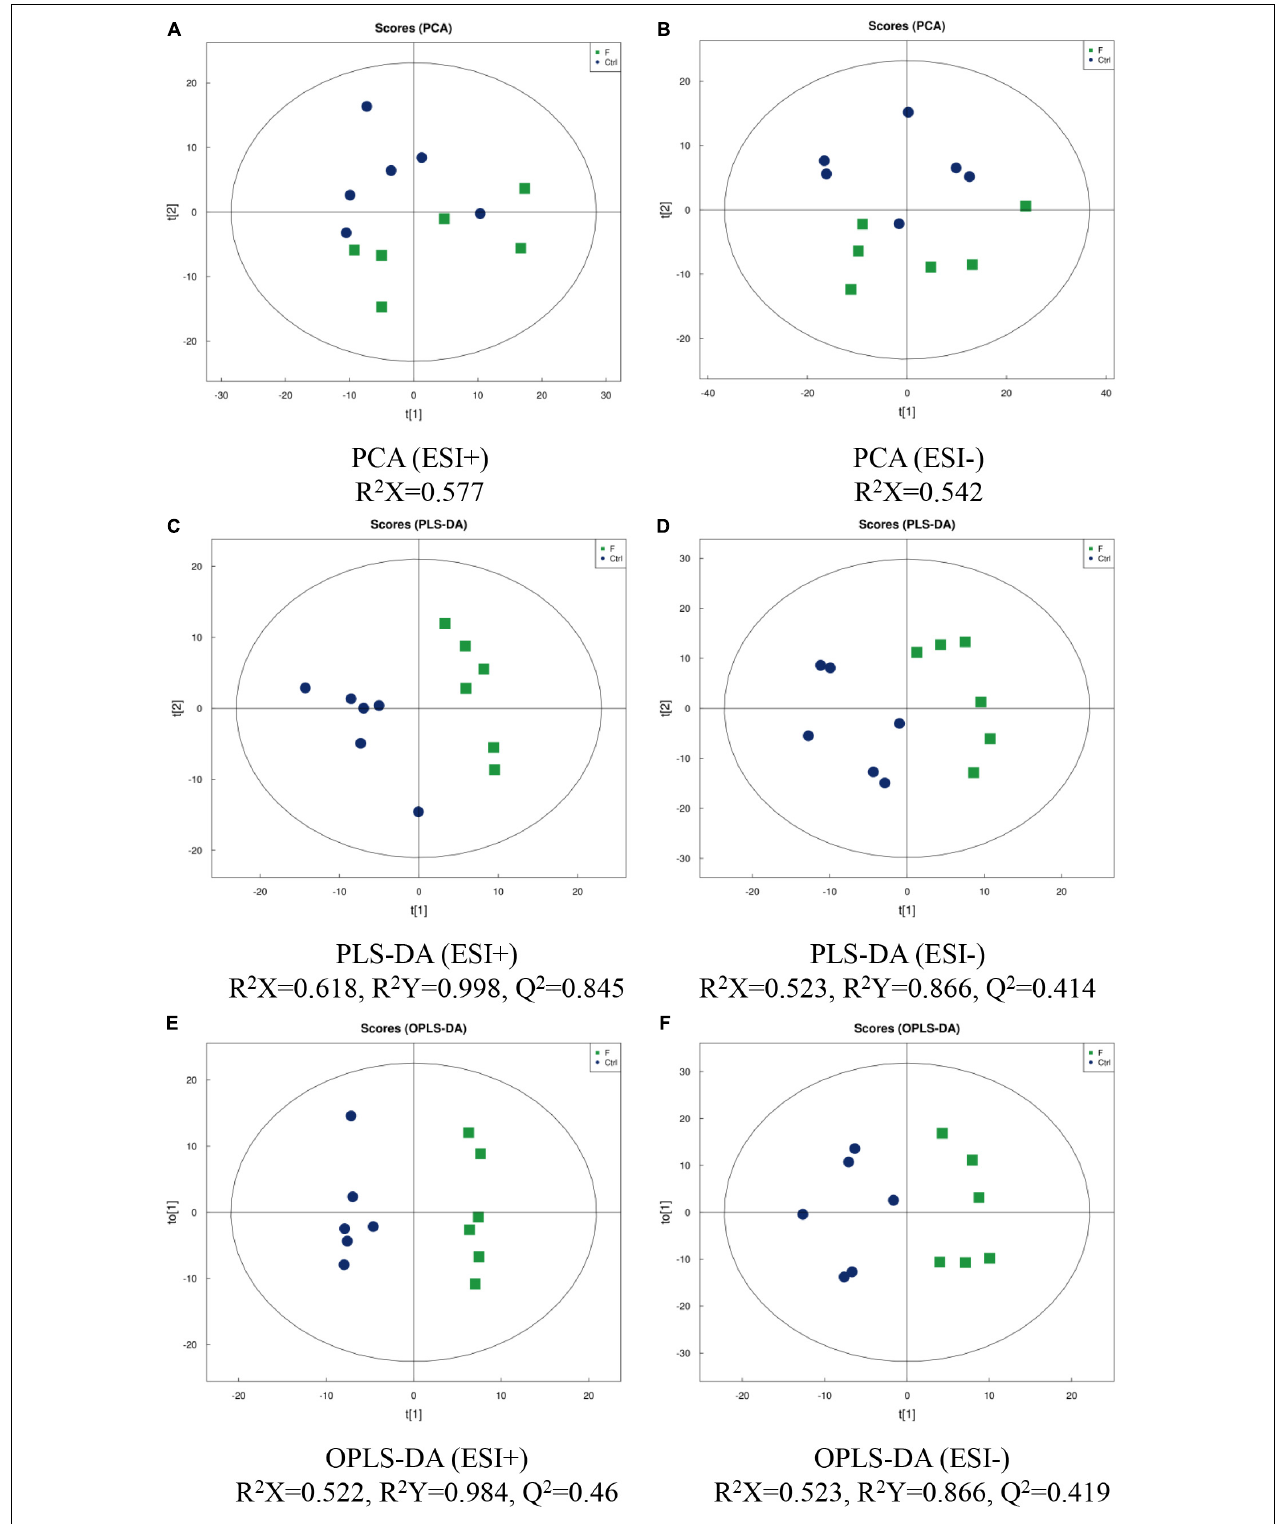
FIGURE 2 | Score plots of PCA, PLS-DA and OPLS-DA of LMH cells infected with FAdV-4. PCA [ (A) positive ion mode-ESI + ; (B) negative ion mode-ESI-], PLS-DA [ (C) positive ion mode-ESI + ; (D) negative ion mode-ESI-], and OPLS-DA [ (E) positive ion mode-ESI + ; (F) negative ion mode-ESI-] models were constructed using LC-MS/MS metabolomics data. Results indicate the separation of control and FAdV-4 group. The ellipses represent 95% confidence intervals of all samples.